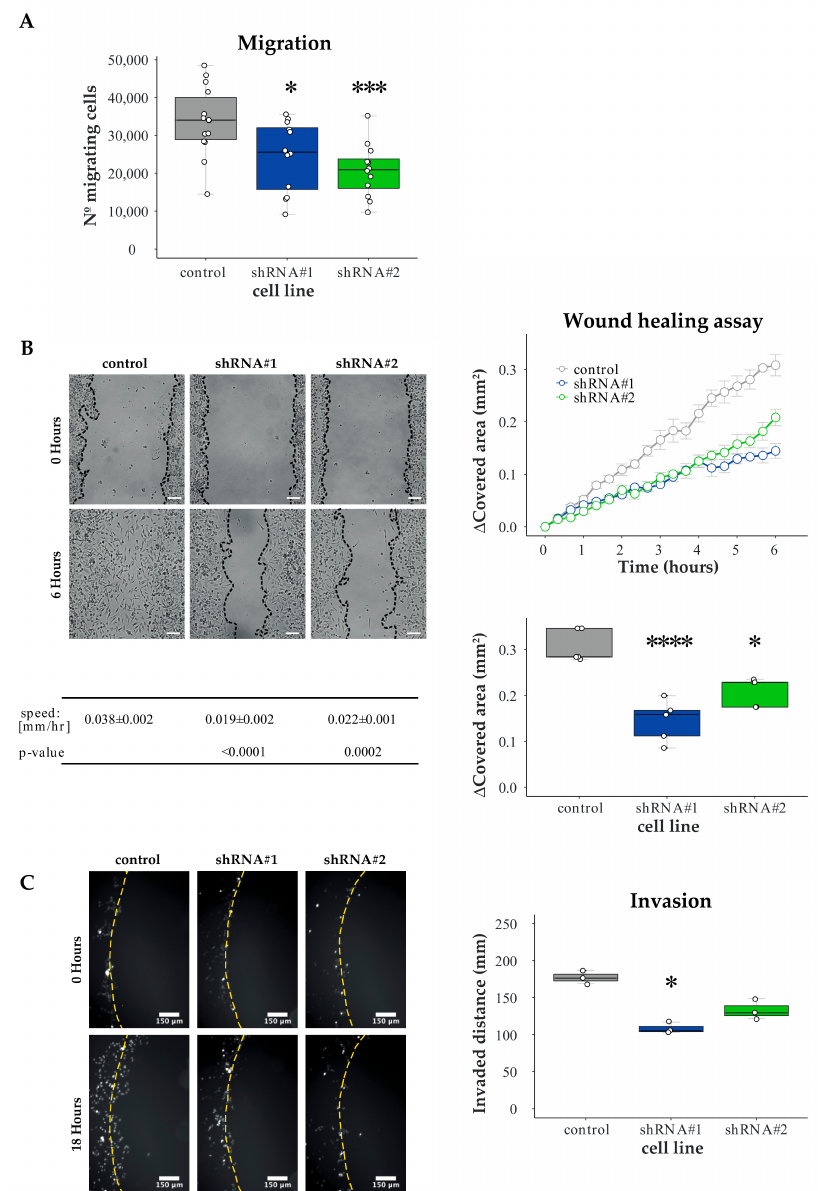
Figure 3. Validation and characterization of HERC1 as a candidate migration and invasion regulatory gene. Cells migratory potential was evaluated by two different experiments. ( A ) Boyden chamber assay: number of migratory cells per Boyden chamber membrane ( n ≥ 12, one-way ANOVA, Dunnett’s multiple comparison test; shRNA #1 p = 0.0180 (*) and shRNA #2 p = 0.0009 (***)). ( B ) Wound healing assay: (Top Left) representative areas in a wound healing experiment at the indicated time points, scale bar = 100 µ m; (Top Right) wound covered area (mm 2 ) at the indicated time points; (Bottom Left) wound edge closing speed ( n = 5, one-way ANOVA, Dunnett’s multiple comparison test; shRNA #1 p < 0.0001 (****) and shRNA #2 p = 0.0002 (***)); and (Bottom Right) wound covered area (mm 2 ) at endpoint ( n = 5, one-way ANOVA, Dunnett’s multiple comparison test; shRNA #1 p < 0.0001 (****) and shRNA #2 p = 0.0024 (*)). ( C ) Agar spot assay: cells were seeded in wells with drops of solidified agar and invaded along the bottom surface under the agar. Pictures were taken along the edge and the displacement is the extent of invasion under agar from the spot edge to cells final position: (Left) representative area showing cell invasion into an agar spot at the indicate time points, scale bar = 150 µ m; and (Right) cells mean displacement at the end of the experiment ( n = 3, Kruskal–Wallis, Dunn’s multiple comparison test; shRNA #1 p = 0.0146 (*) and shRNA #2 p =